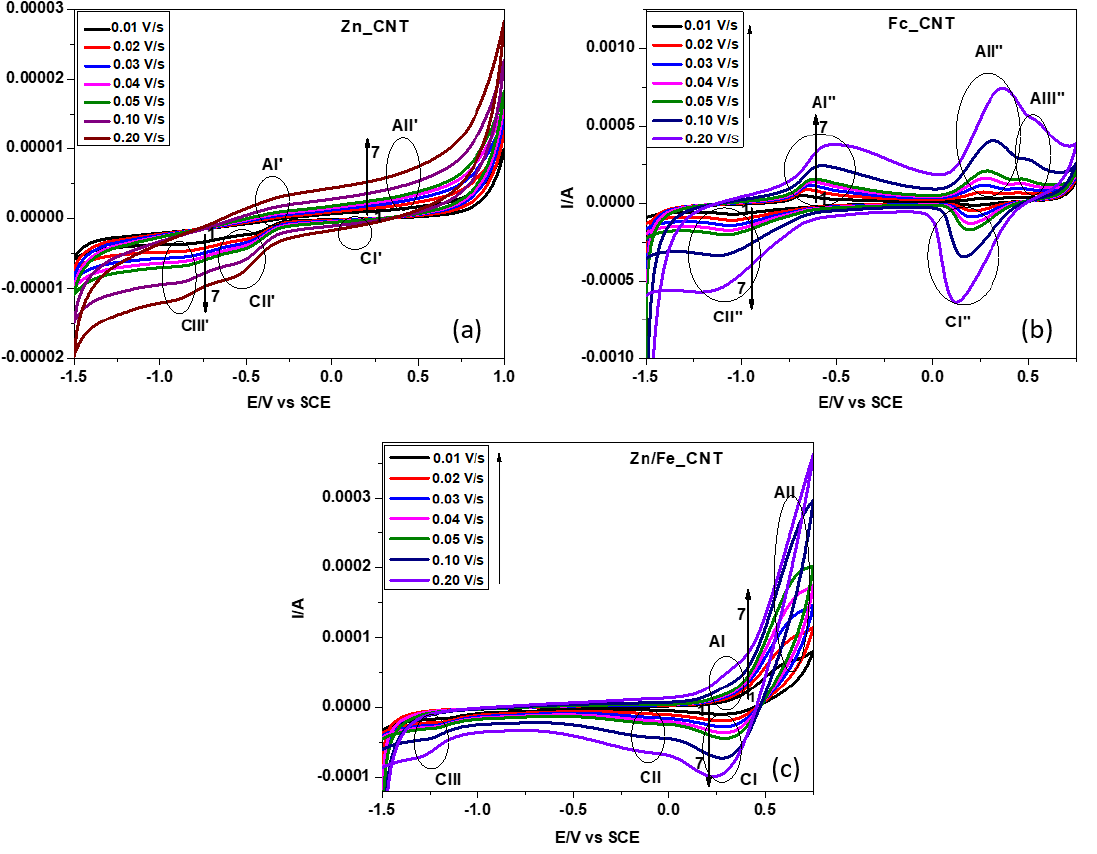
Figure 5. CVs recorded within potential window from − 1.5 V to +1.0 V vs. SCE in 0.1 M NaOH sup- porting an electrolyte at various scan rates (0.01, 0.02, 0.03, 0.05, 0.1 and 0.2 V · s − 1 (curves 1–7)) on the electrodes: ( a ) Zn_CNT paste electrode; ( b ) Fc_CNT paste electrode; ( c ) Zn/Fe_CNT paste